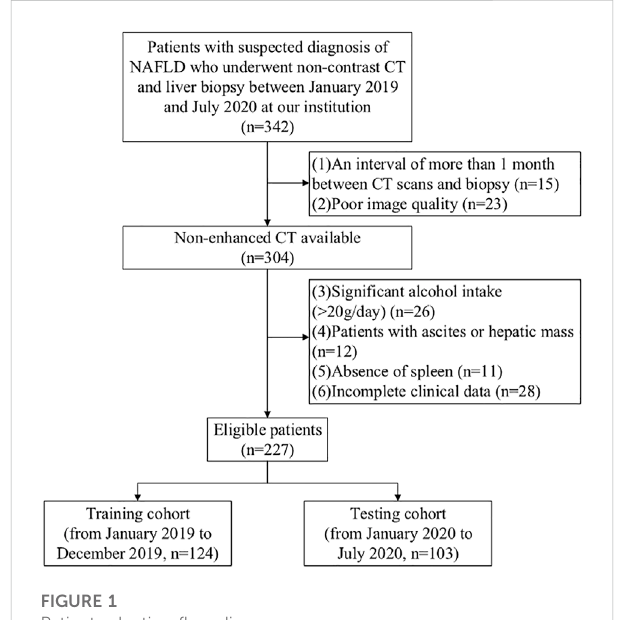
FIGURE 1 Patient selection fl ow